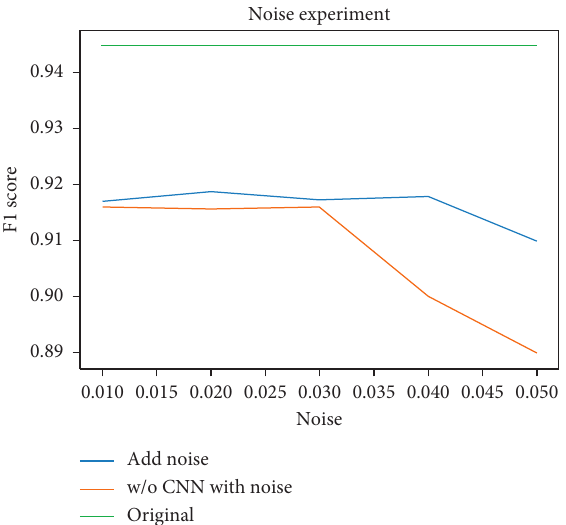
Figure 4: Noise experiment. The green line is the score of the original model without any processing; the value is as high as 0.945. The blue line is the score of the noise with different variances. The orange line is the score of the model without 1D convolution in data preprocess as well as added noises.